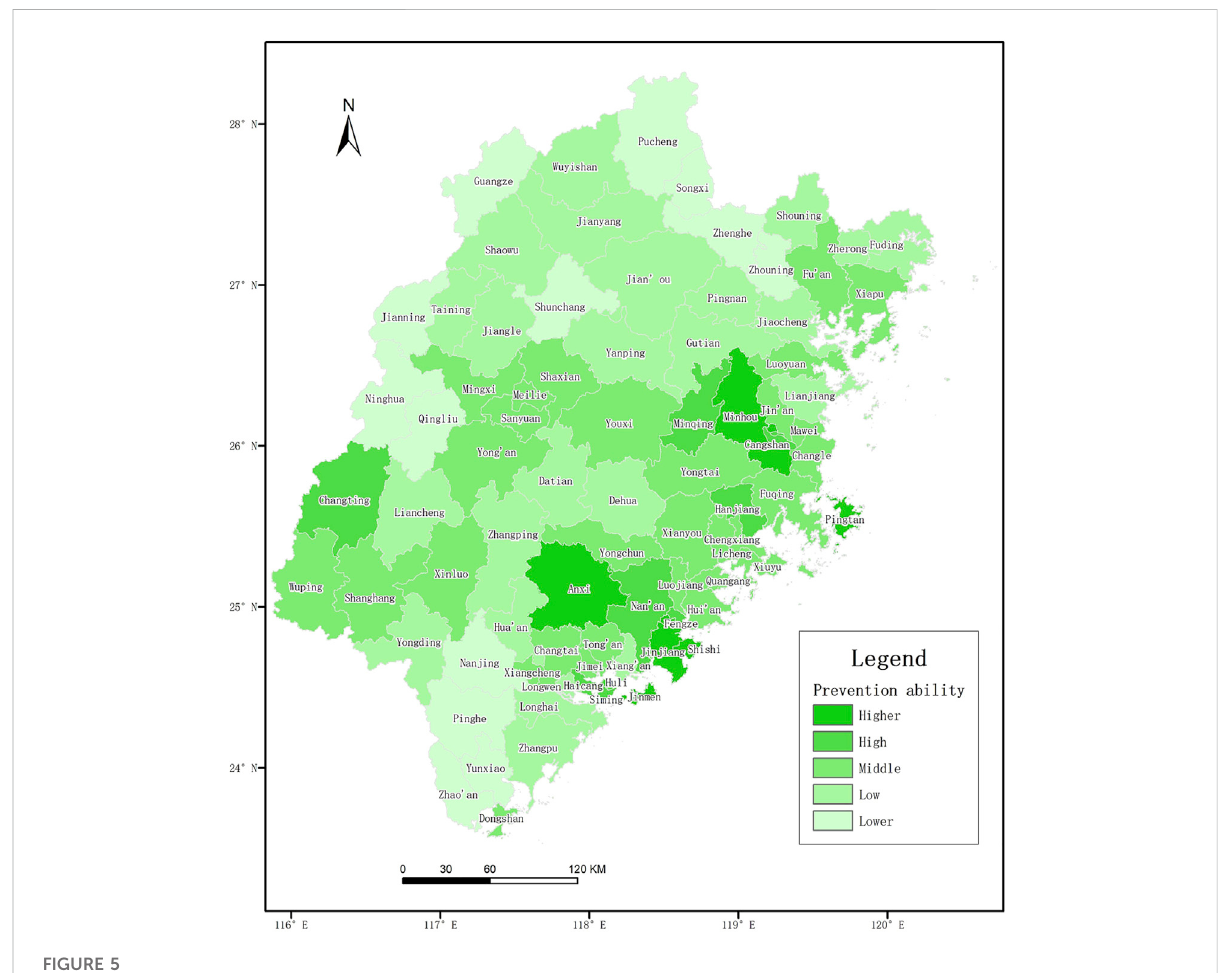
FIGURE 5 Spatial distribution pattern of the disaster prevention and mitigation ability.